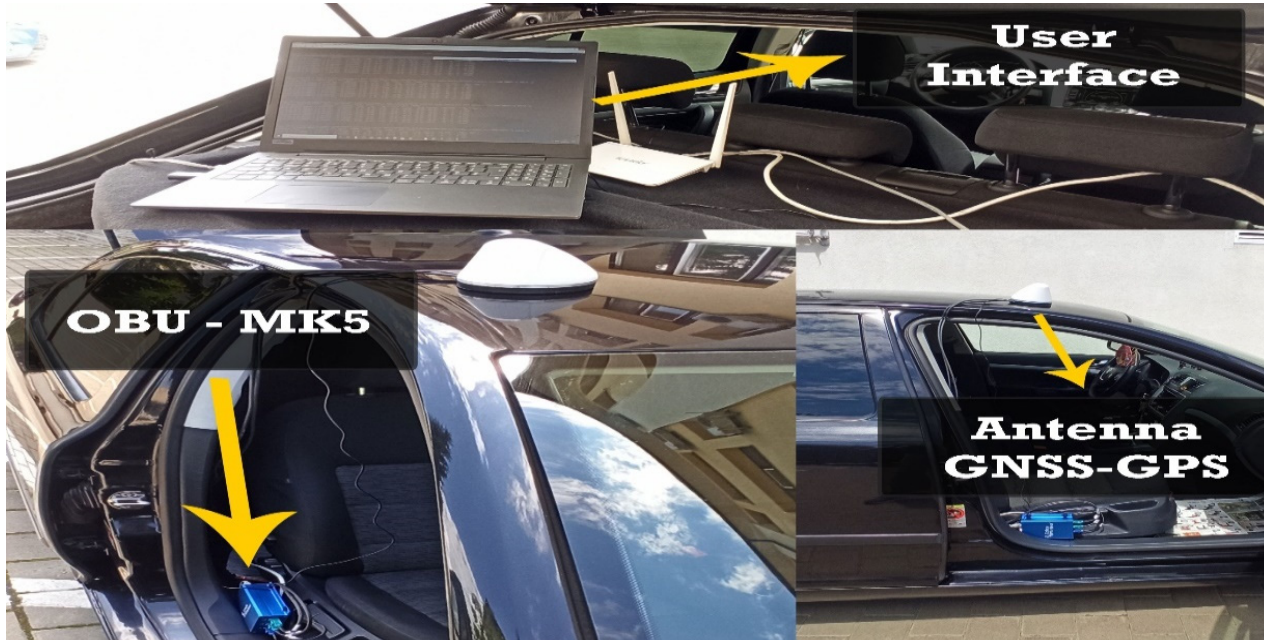
Figure 24. System configuration and integration in the passenger compartment (reception).